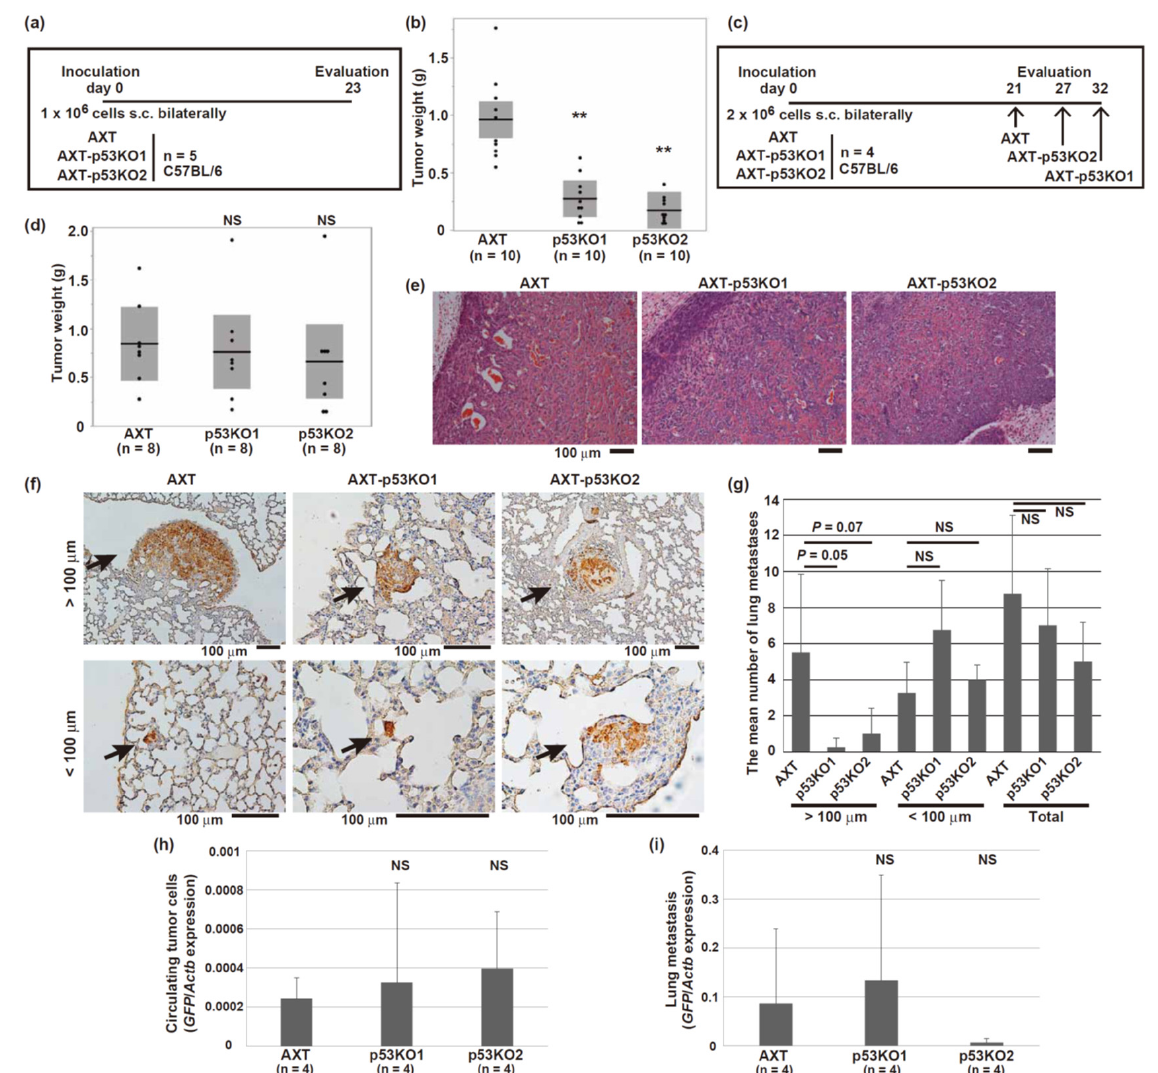
Figure 5. Depletion of mutant p53 did not prevent osteosarcoma progression in vivo. ( a , c ) The schedule of cell inoculation into syngeneic C57BL/6 mice. ( b , d ) The dot plot of weight of primary tumors. The horizontal bars and boxed regions show the means and the 95% confidence intervals, respectively. ( e ) Hematoxylin-eosin (H&E) staining of primary tumors in the mice inoculated with the indicated cells. ( f ) Representative images of the lung metastatic lesions stained with GFP. The arrows indicate lung metastases classified according to whether the major axis was larger than 100 µ m. ( g ) The number of metastases present throughout a randomly sliced section was counted. The data represent the mean values from the right lungs of four mice. ( h , i ) RT and real-time PCR analysis of GFP mRNA in whole blood ( h ) or a lung ( i ) derived from the mice inoculated with the indicated cells. (** p < 0.005; NS, not